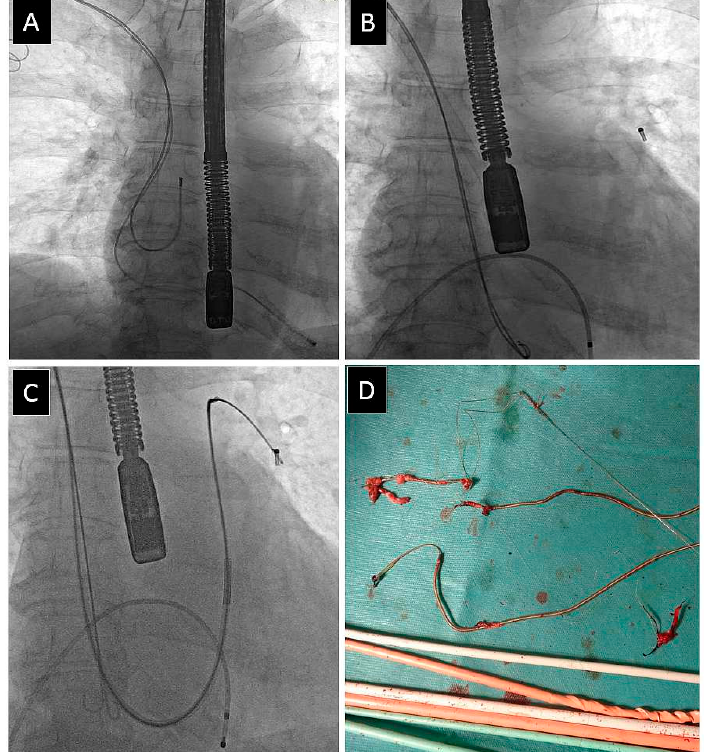
Figure 7. Loss of broken lead fragment. Image before the start of the TLE ( A ). The distal lead fragment detached during the lead dissection may flow in the bloodstream into the pulmonary circulation ( B ). It can usually be captured with a lasso catheter ( C ) and removed from the circulatory system ( D ) [38].